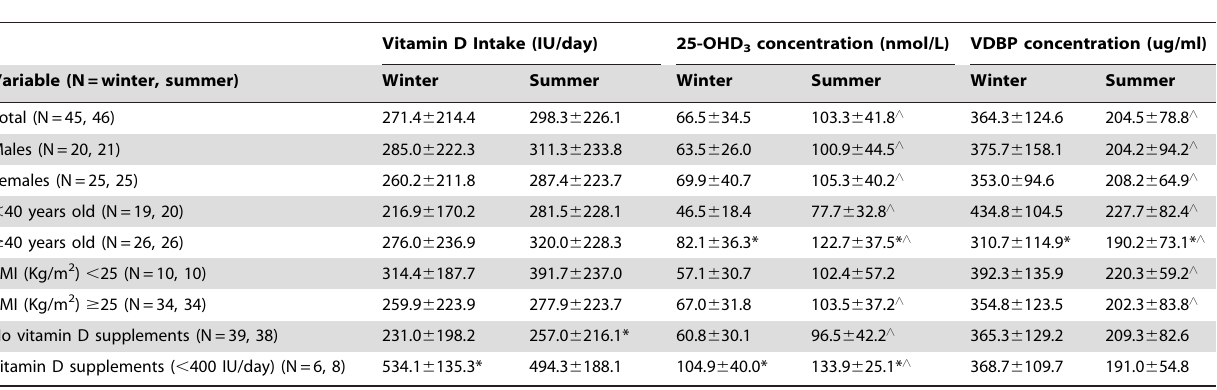
Table 1. Vitamin D intake, and serum concentrations of 25-OHD 3 and VDBP for the study participants by demographic group and season (mean 6 standard deviation).